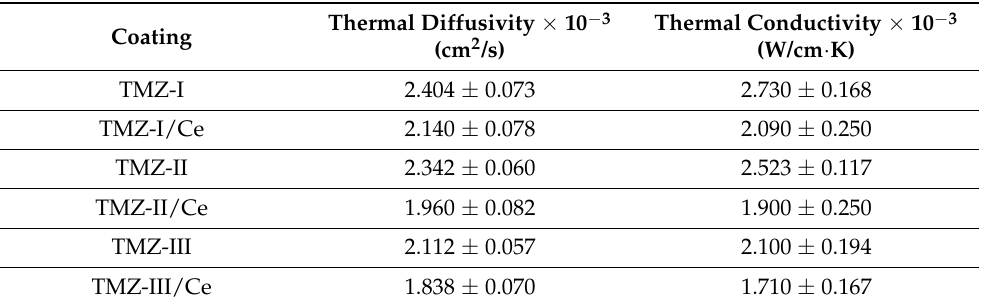
Table 1. Thermal parameters values for investigated TMZ coatings were determined using non- destructive photothermal radiometry.